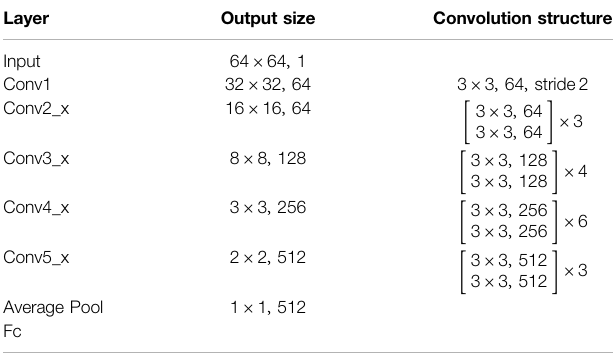
TABLE 1 | ResNet-34 model structure.